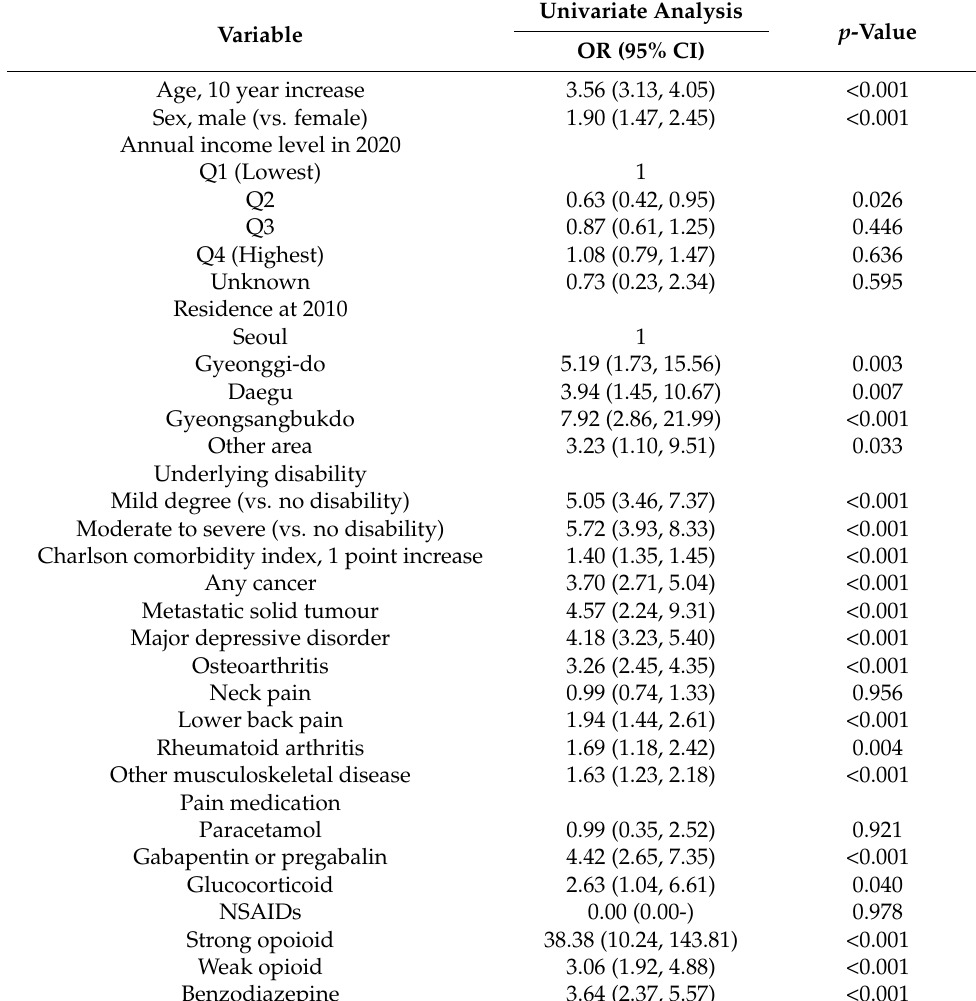
Table 2. Univariate logistic regression analysis for in-hospital mortality among COVID-19 patients in South Korea. Univariate Analysis p -Value Variable OR (95% CI) Age, 10 year increase 3.56 (3.13, 4.05) <0.001